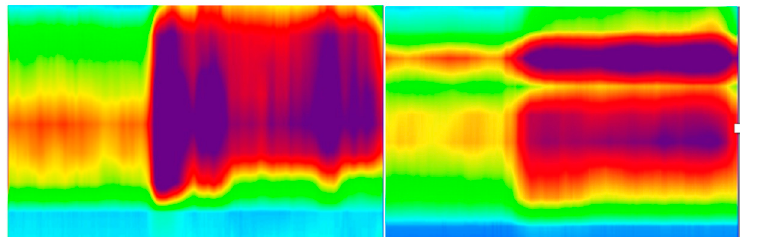
Figure 4. High-resolution manometry of two patients suggesting dyssynergia, both being unable to decrease anal pressure (relax) during the push manoeuvre.